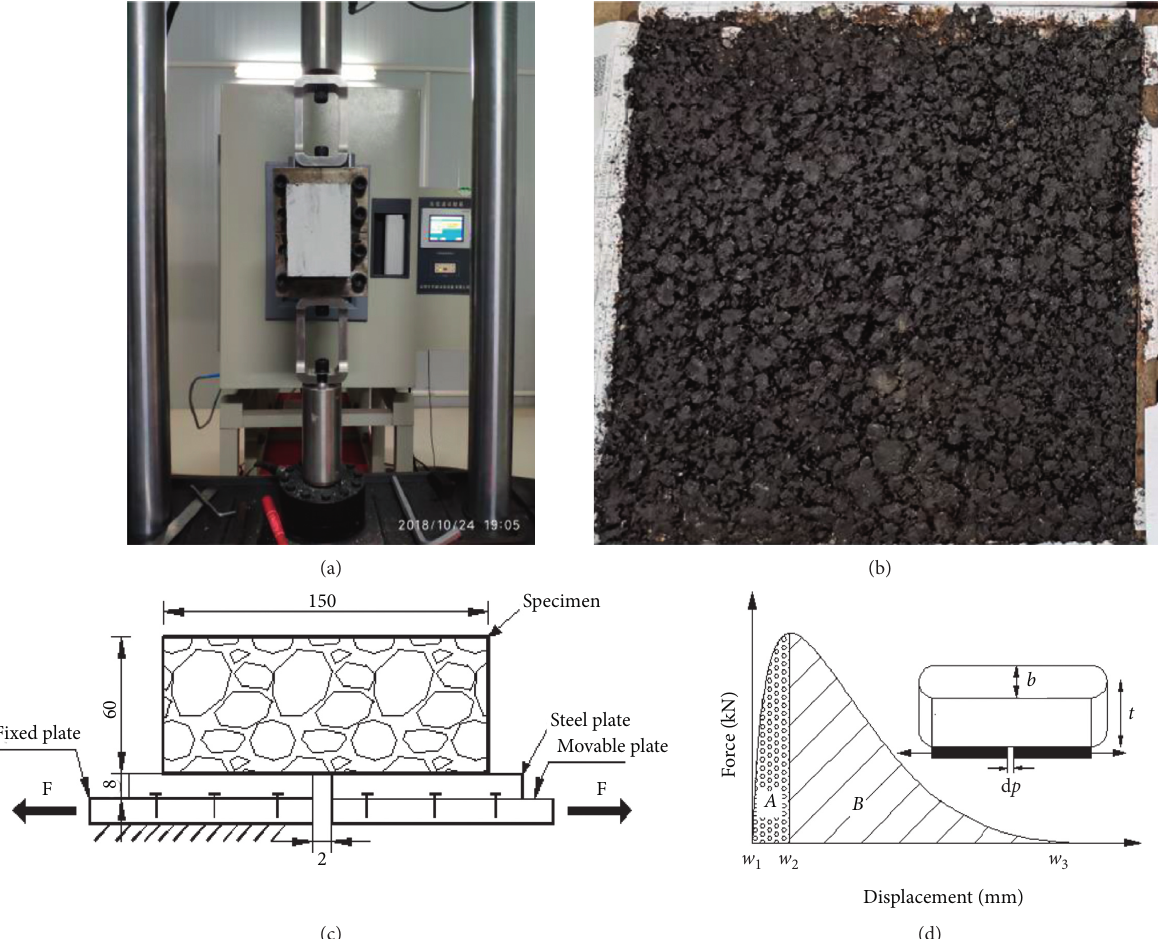
Figure 1: OT schematic diagram (mm), sample setup, and load vs. displacement during a typical monotonic OT